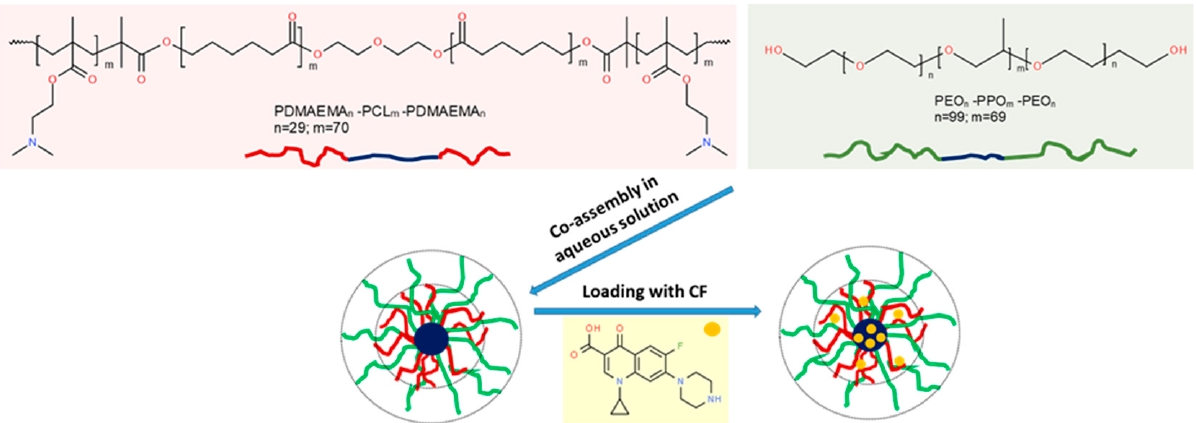
Table 1. Critical micellization concentration, hydrodynamic diameter, and ζ -potential values of SCPMs and MPMs based on PDMAEMA-PCL-PDMAEMA and Pluronic F127 triblock copolymers. Measurements were performed at 25 ◦